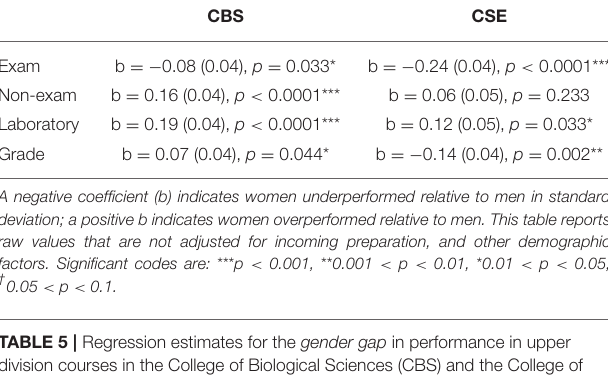
TABLE 5 | Regression estimates for the gender gap in performance in upper division courses in the College of Biological Sciences (CBS) and the College of Science and Engineering (CSE) across different assessment methods, including the overall course grade.